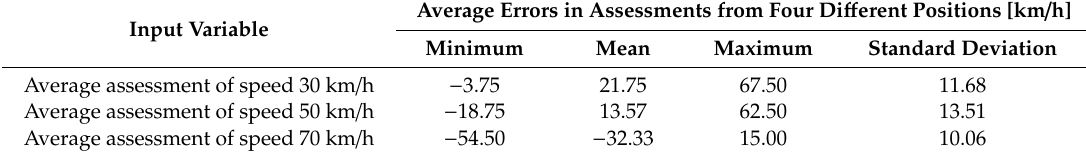
Table 1. Description of a sample considering errors in speed assessment.